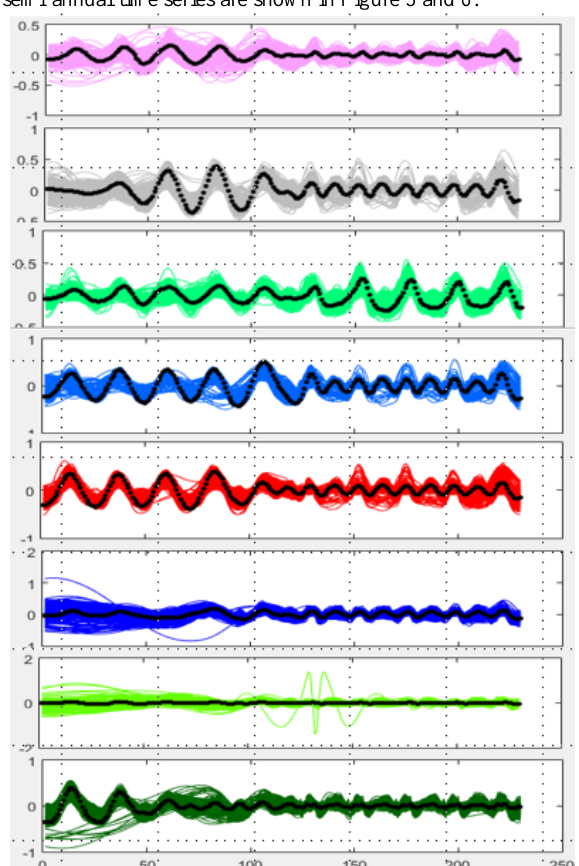
The K-means clustering results and the clustering centers of the semi-annual time series are shown in Figure 5 and